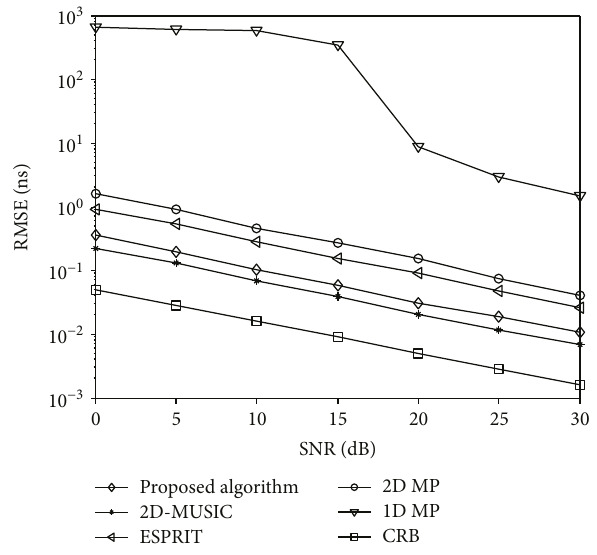
Figure 10: Performance comparison of di ff erent algorithms for TOA estimation.